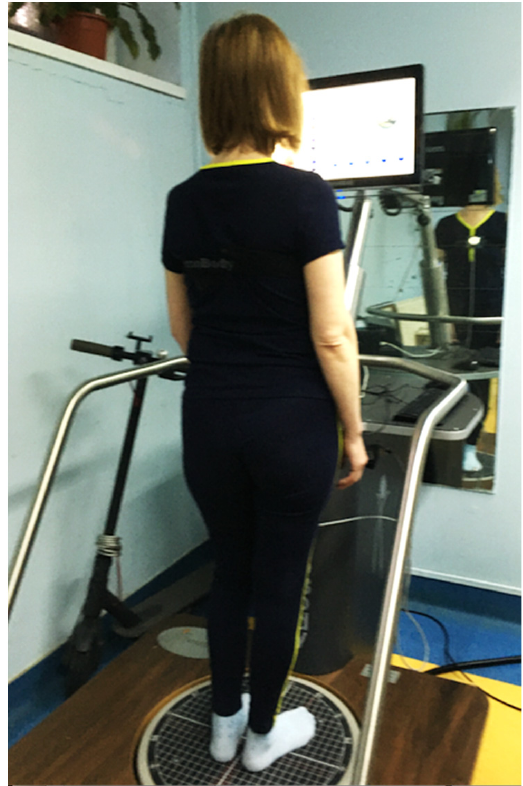
Figure 2. Patient from the clinical trial during a session of visual feedback balance training and stabilometric assessment using the Prokin system; original picture taken by the author EE Mihai in the Department of Physical and Rehabilitation Medicine, Elias University Emergency Hospital, Bucharest, using a digital camera (Nikon D3300; Nikon Corporation, Tokyo,